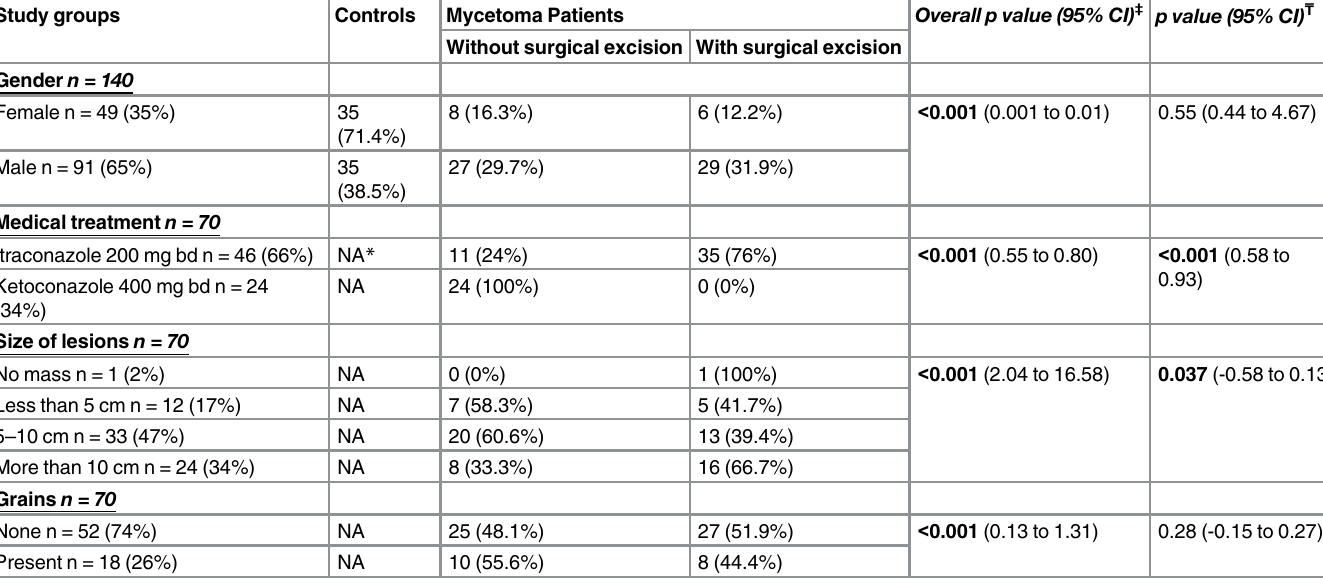
Table 1. Distribution of gender, medical treatment, size of lesions and presence of grains among the study population. Study groups